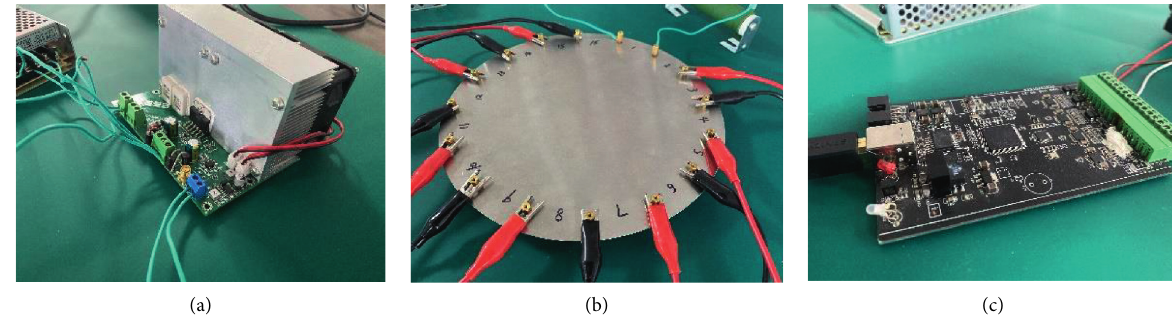
Figure 8: Experimental platform diagram. (a) The excitation unit; (b) the sensor electrode array; (c) the signal acquisition and processing unit.